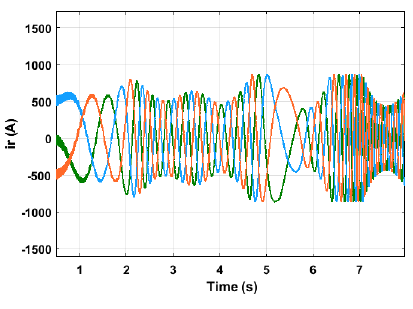
Figure 8i. Rotor Current without Power management Figure 8j. Rotor Current with Power management maximum temperature limit (rotor current and stator current) and limit isolation (rotor voltage limit).